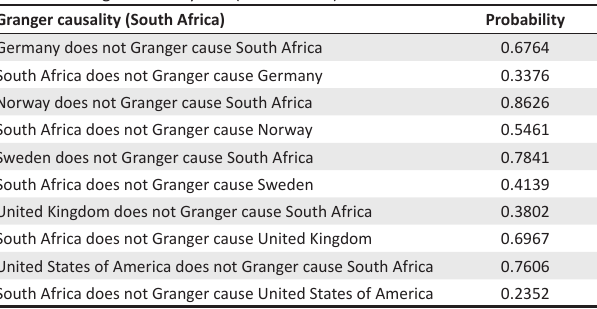
TABLE 4: Granger causality test (South Africa).